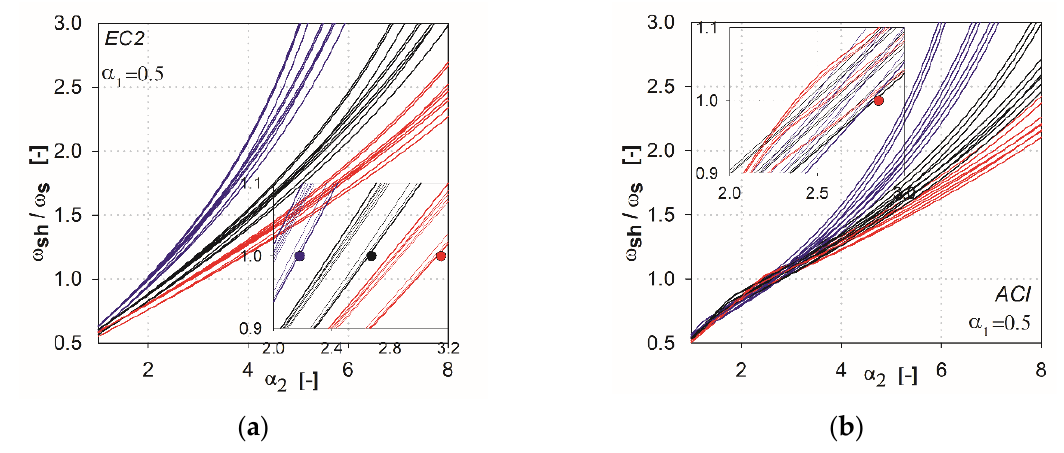
Figure 7. Graphs obtained for the parameter 𝛼 1 = 0.5 : ( a ) for the EC2 standard; ( b ) for the ACI code.